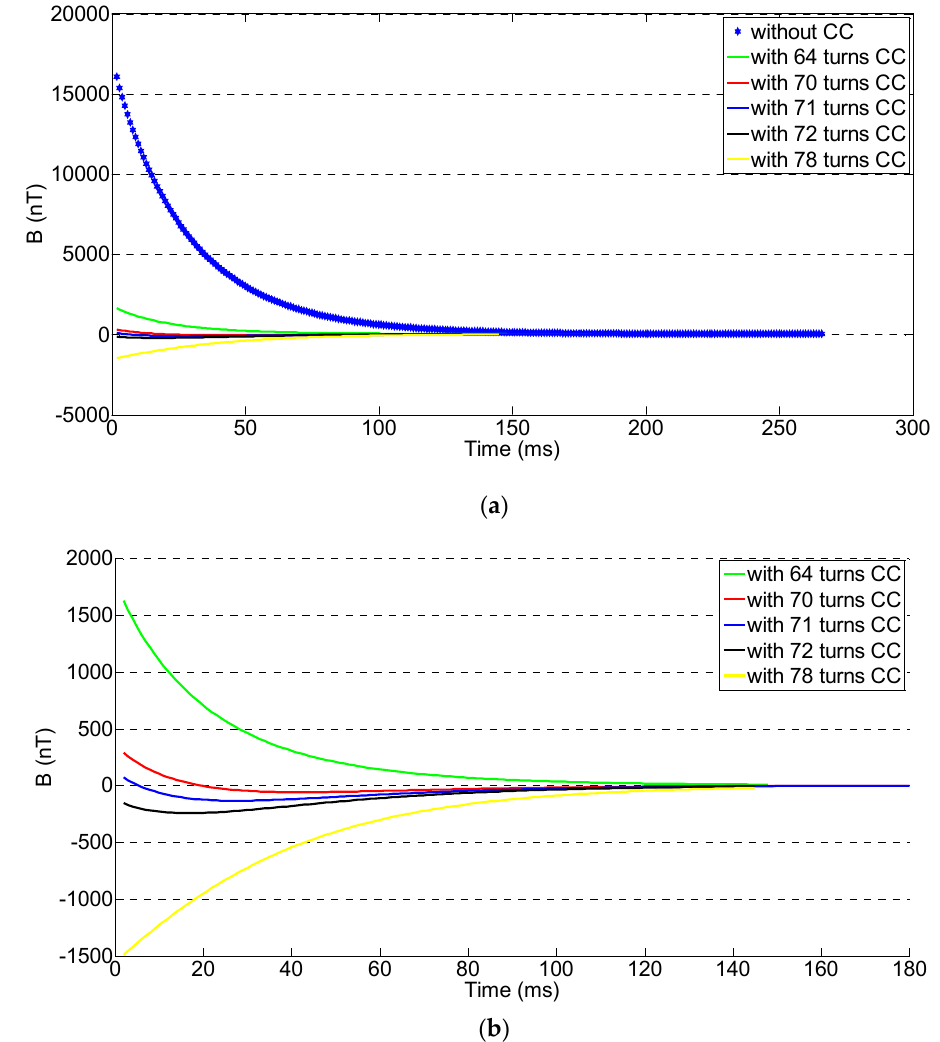
Figure 3. Comparison of residual magnetic field component in z-direction with different number of turns of CC after 2 ms; ( a ) including the decay curve without CC; ( b ) excluding the decay curve without CC.